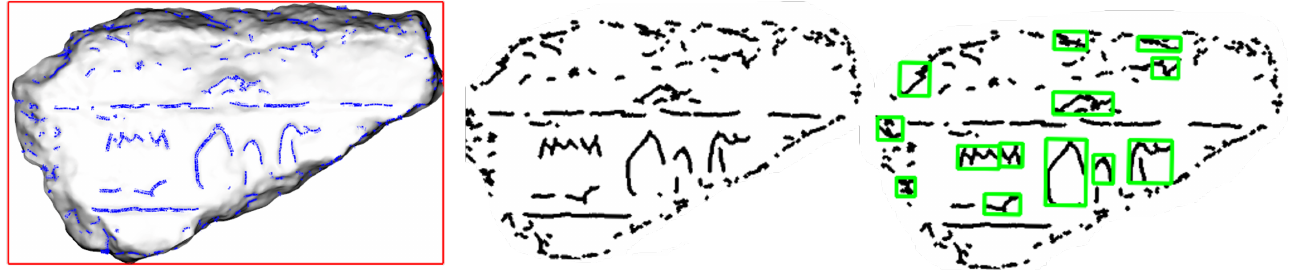
Figure 6. Left: Valley lines of a decorated fragment. Center: Lines projected onto an image. Right: Segmented connected components delineated with green